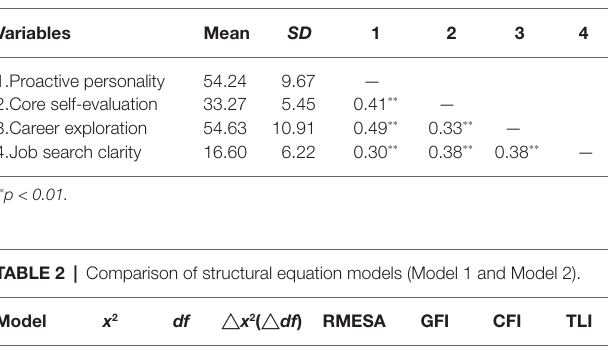
TABLE 1 | Means, standard deviations (SD) and correlations of all variables.